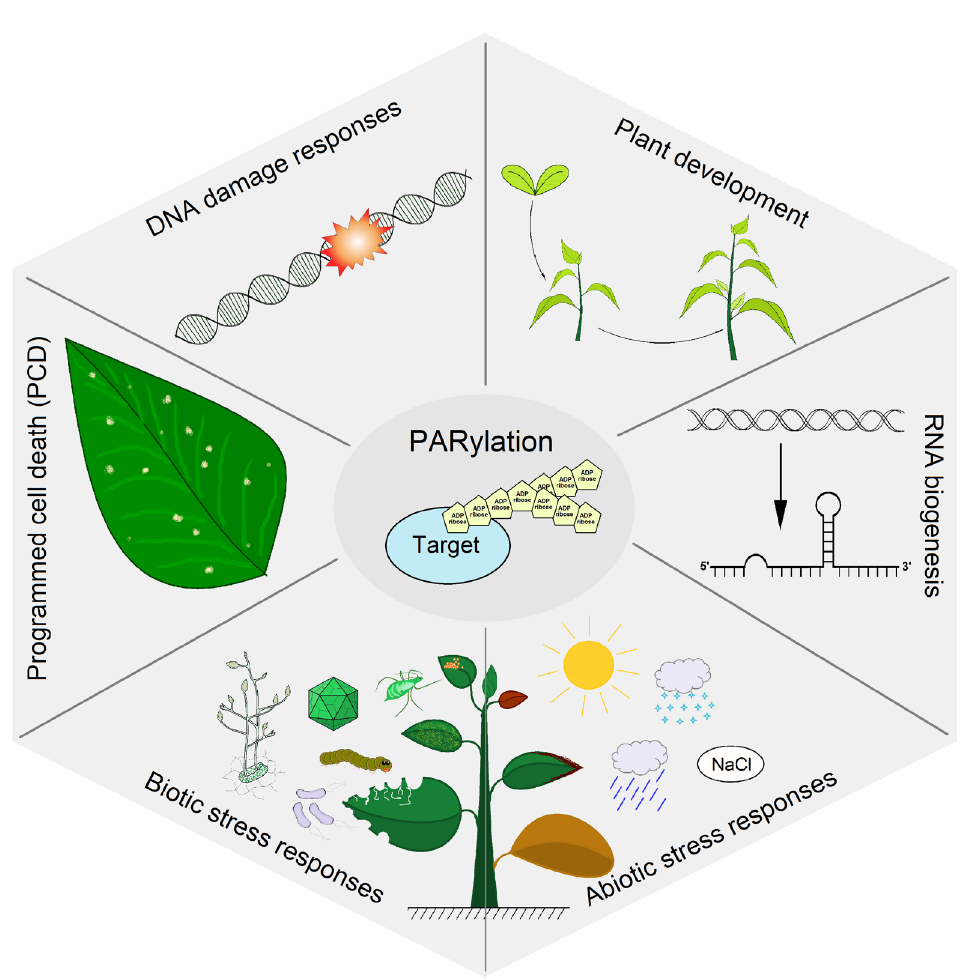
Figure 2. The role of the PARylation in regulating plant functions.